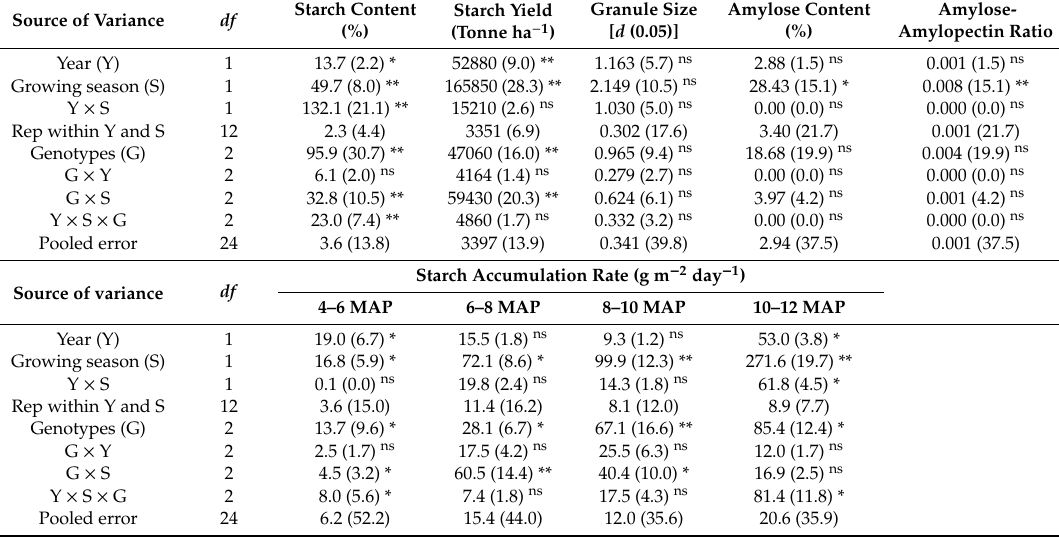
Table 2. Mean squares from the combined analyses of starch content, starch yield, granule size, amylose, amylose-amylopectin ratio at final harvest and starch accumulation rate during 4–6, 6–8, 8–10 and 10–12 months after planting (MAP) for three cassava genotypes in early and post rainy seasons for two